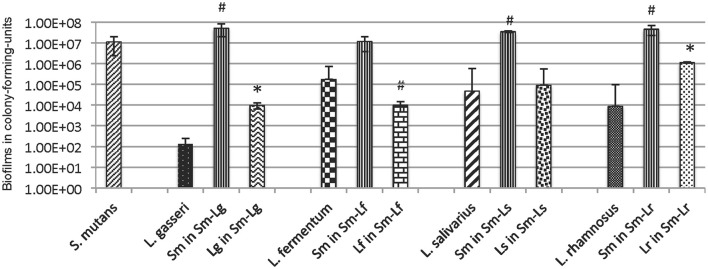
Forty eight-hour biofilms of L. gasseri (Lg), L. fermentum (Lf), L. salivarius (Ls) and L. rhamnosus (Lr) in mono-species and dual-species with S. mutans (Sm) grown in BM plus glucose (18 mM) and sucrose (2 mM) on glass slides vertically deposited in 50 ml Falcon tubes. Data represent the average (±standard deviation in error bars) of at least three separate experiments, with * and # indicating statistical difference at P < 0.001 and 0.05, respectively, when compared to the respective mono-species biofilms.